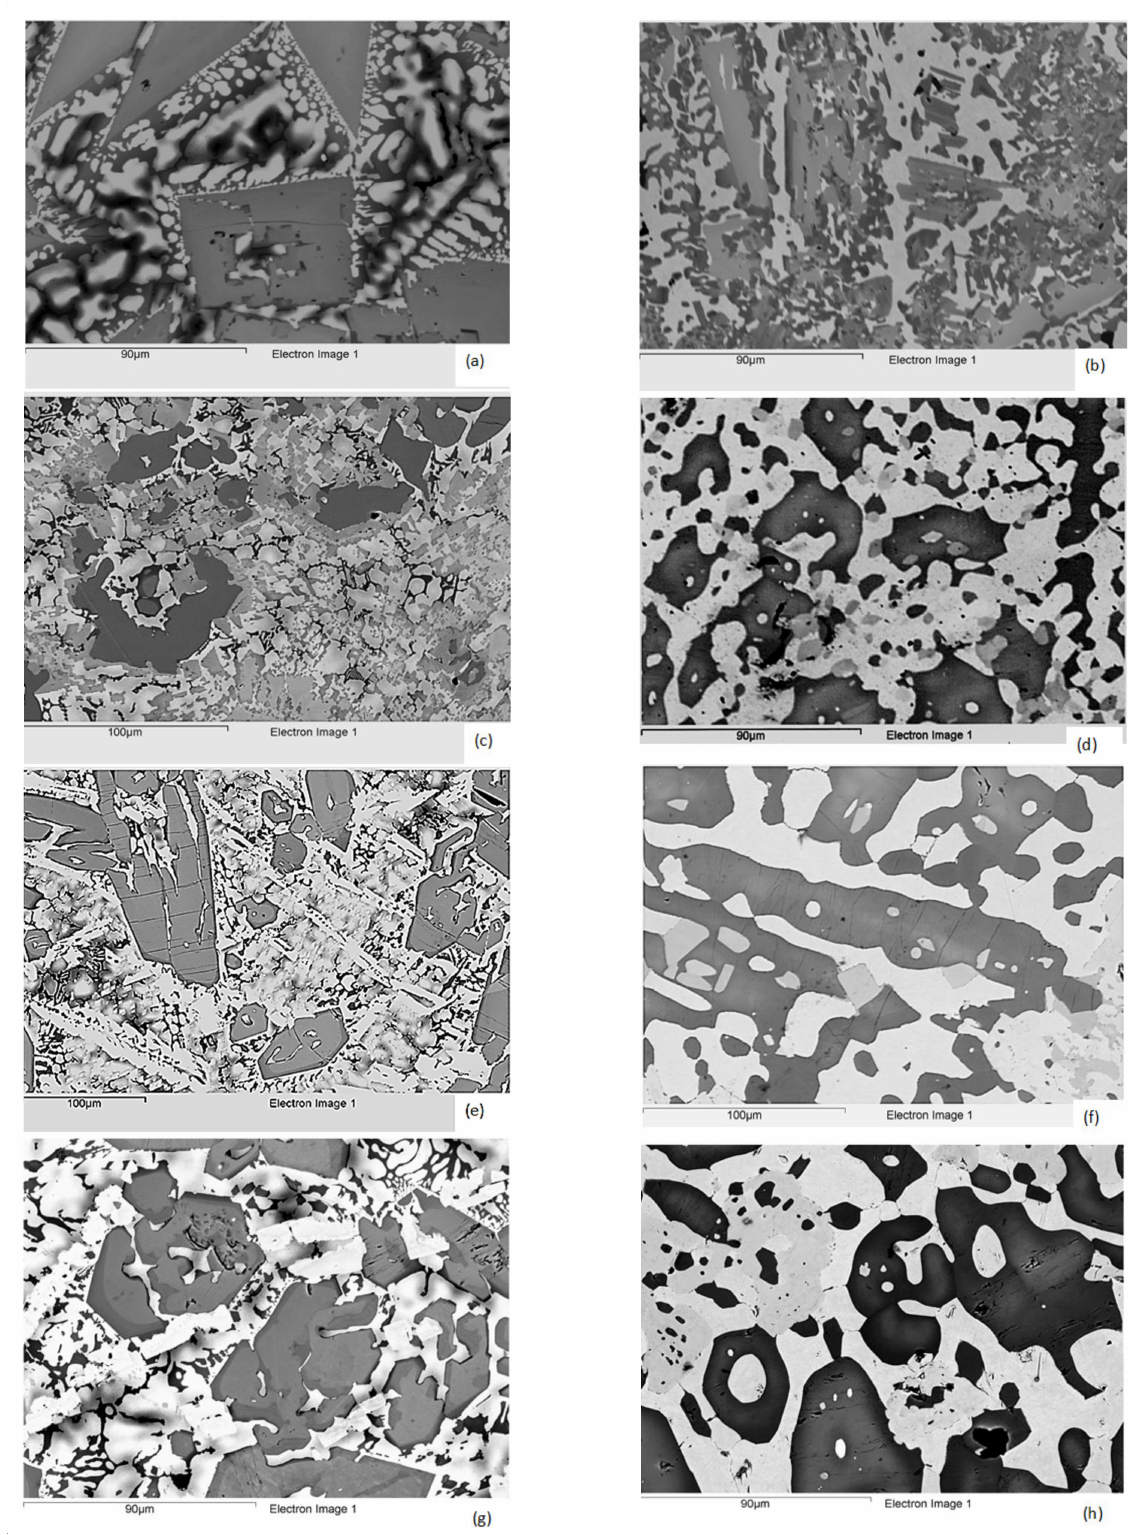
Figure 1. Microstructures of the AC ( a , c , e , g ) and HT ( b , d , f , h ) alloys TT2 ( a , b ), TT3 ( c , d ), TT4 ( e , f ) and TT8 ( g , h ). Note that contrast enhancement has been applied to show different phases. For description of microstructures see